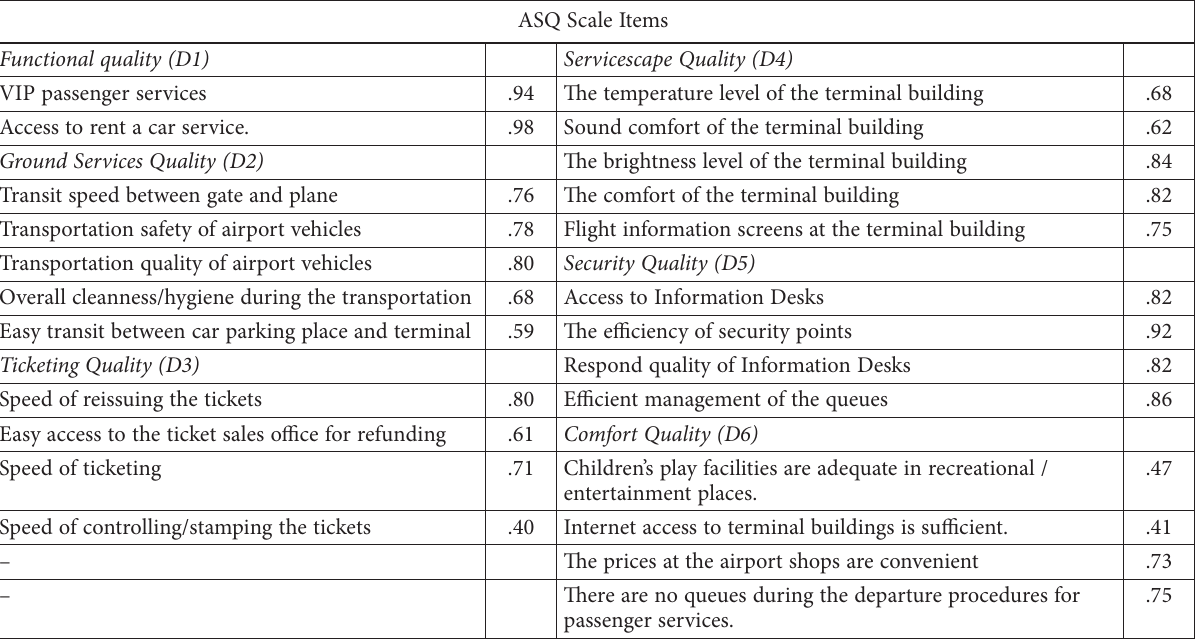
Table 2. The Scale items and CFA factor loadings of airport service quality construct (source: see at Appendix 1 and 2)